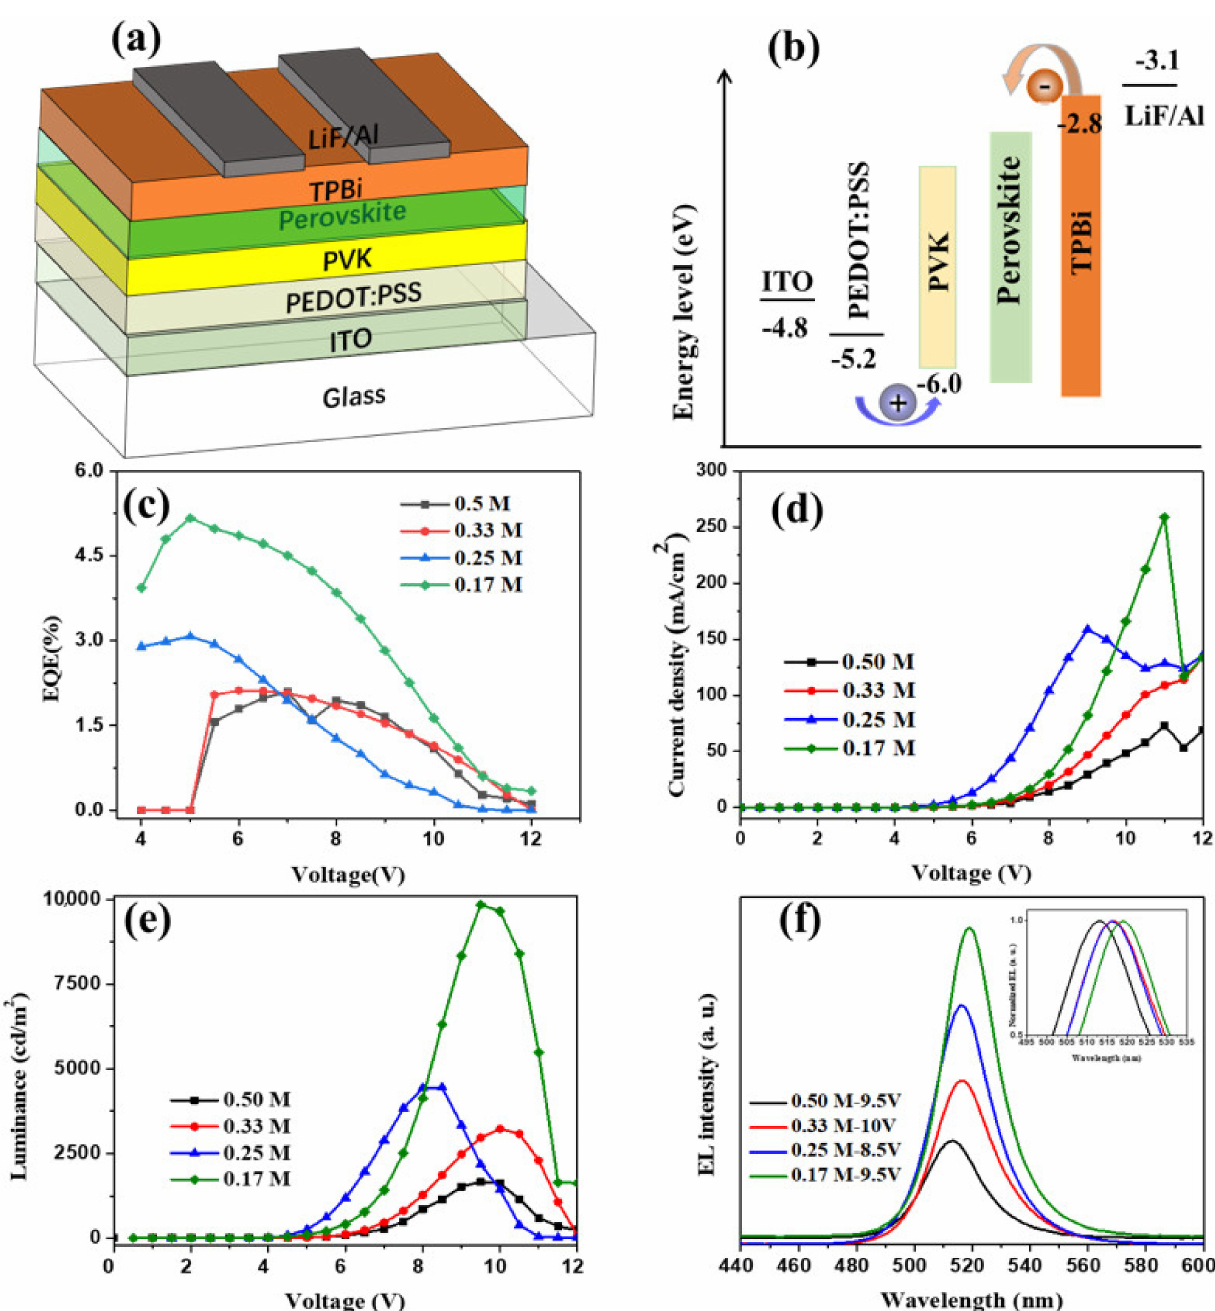
Figure 2. ( a ) The device structure of the perovskite light-emitting diode and ( b ) the energy band diagram of each functional layer of the device. The luminescence characteristics of the PeLEDs pre- pared with different concentrations of perovskite precursor solutions: ( c ) voltage–external quantum efficiency (EQE) curves; ( d ) current density–voltage curves; ( e ) Luminance–voltage curves; and ( f ) EL intensity curves. The inset shows the normalized EL